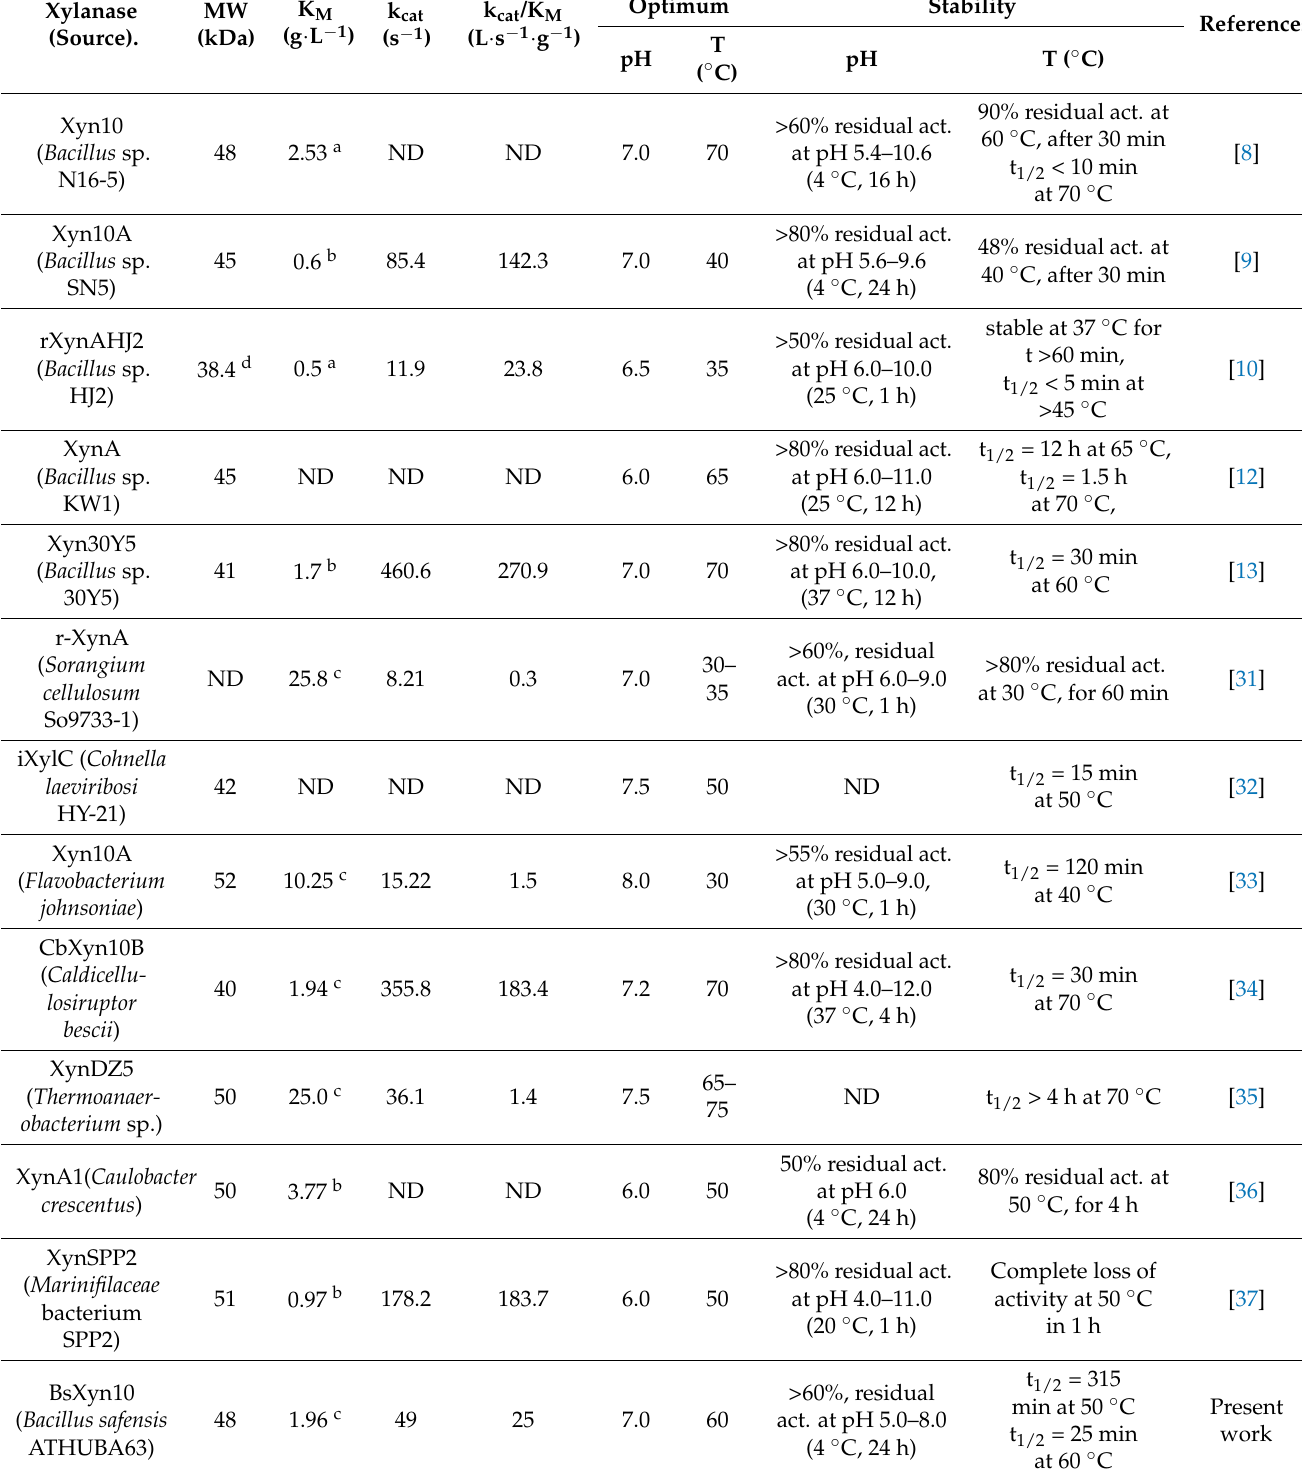
Table 1. The biochemical characteristics of the GH10